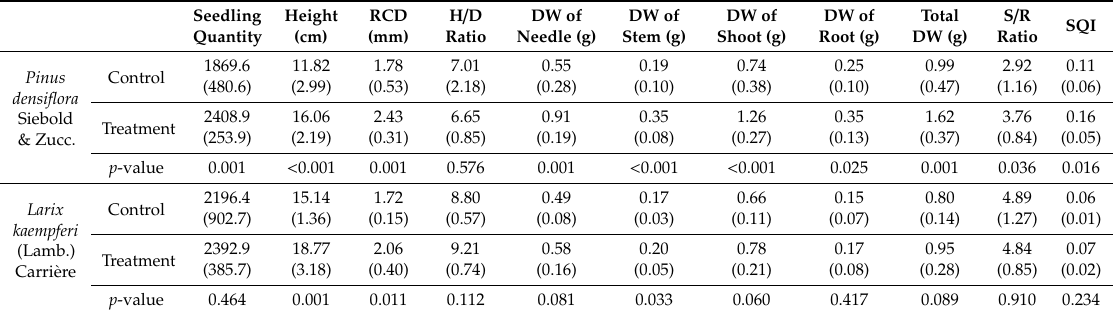
Table 2. Quantity and growth of pine and larch seedlings in the open-field nursery. Seedling Height Quantity